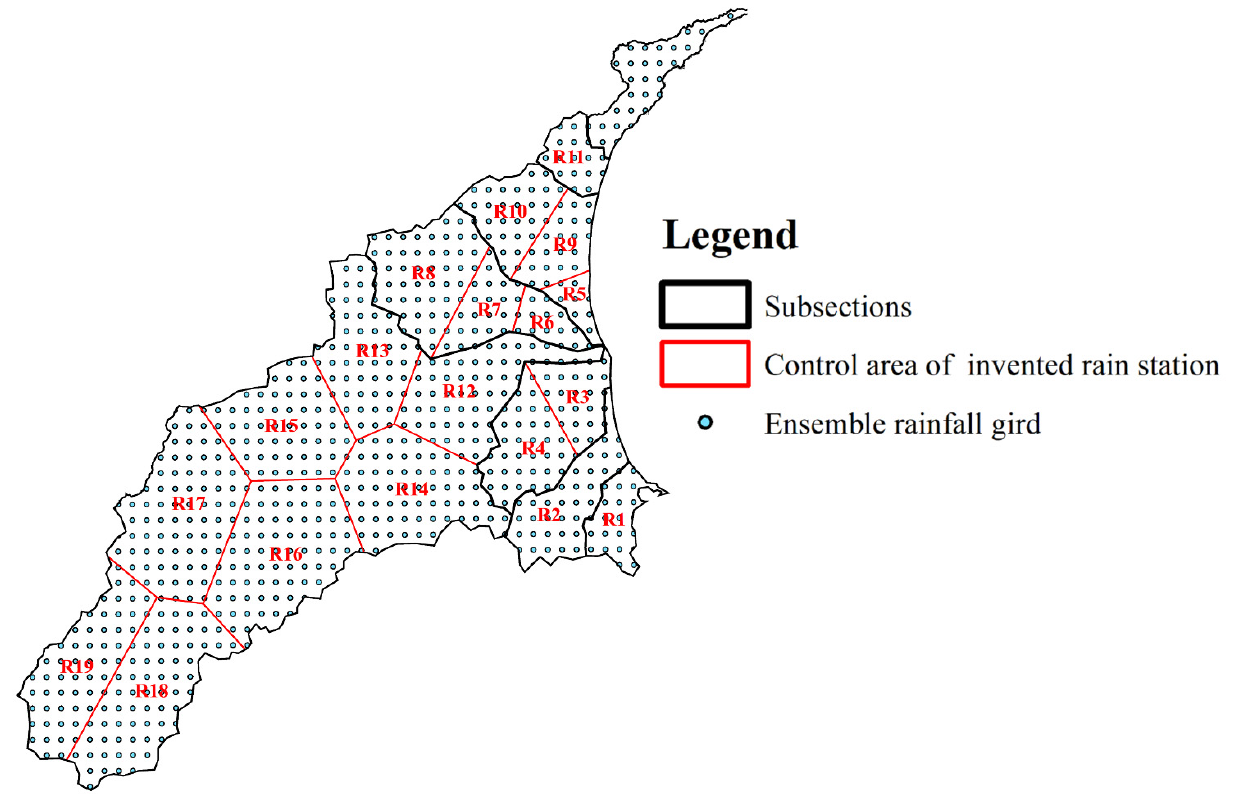
Figure 6. The mesh of ensemble rainfall and virtual rainfall stations settle in this study. Table 2. The optimal parameters of SVM-MSF in nine